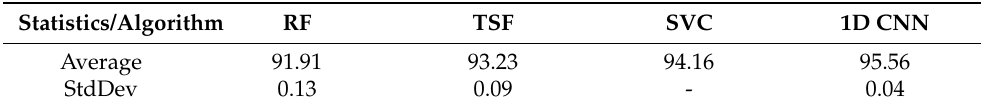
Table 8. Performance statistics of experiment